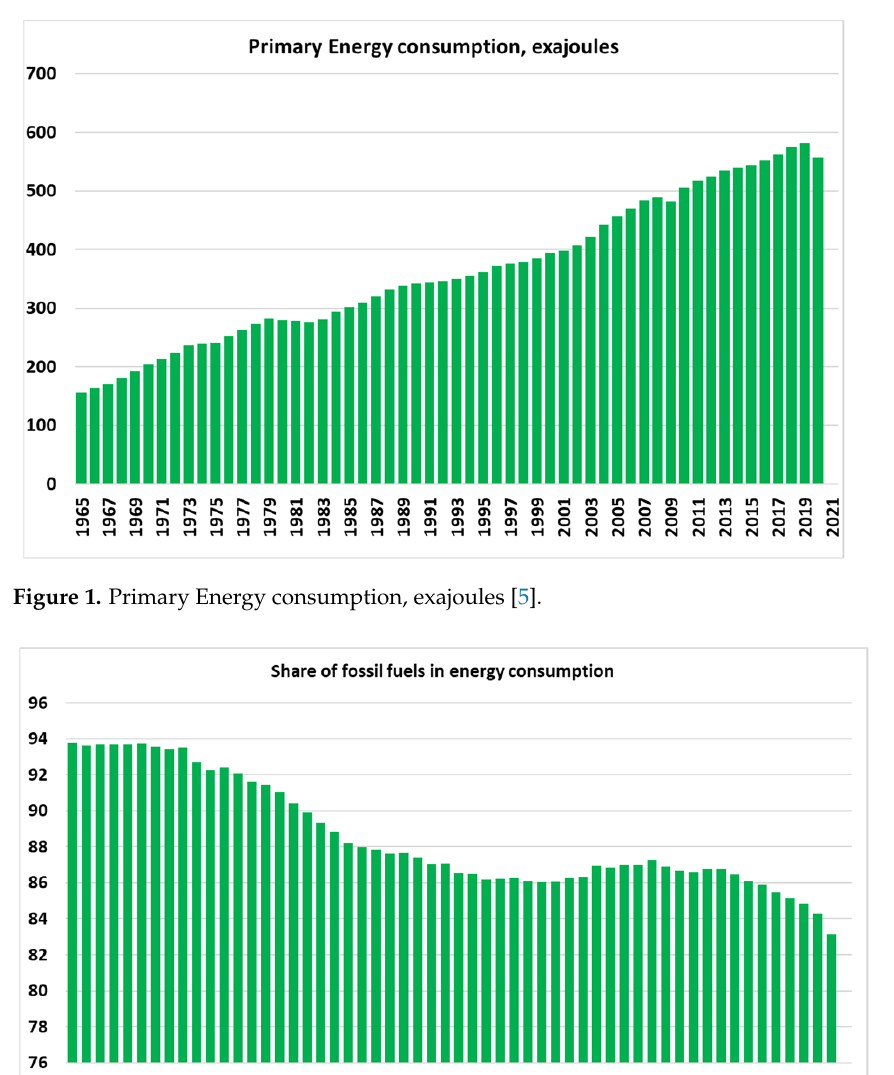
Figure 2. Share of fossil fuels in energy consumption, % [5].